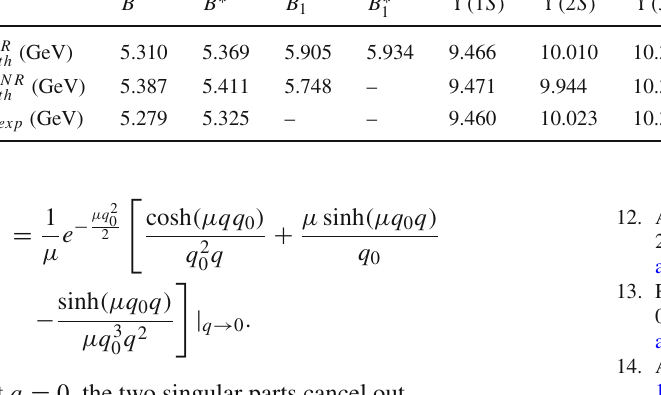
, M NR , and M exp are the mass spectra in the relativized quark model, the nonrelativistic quark th th